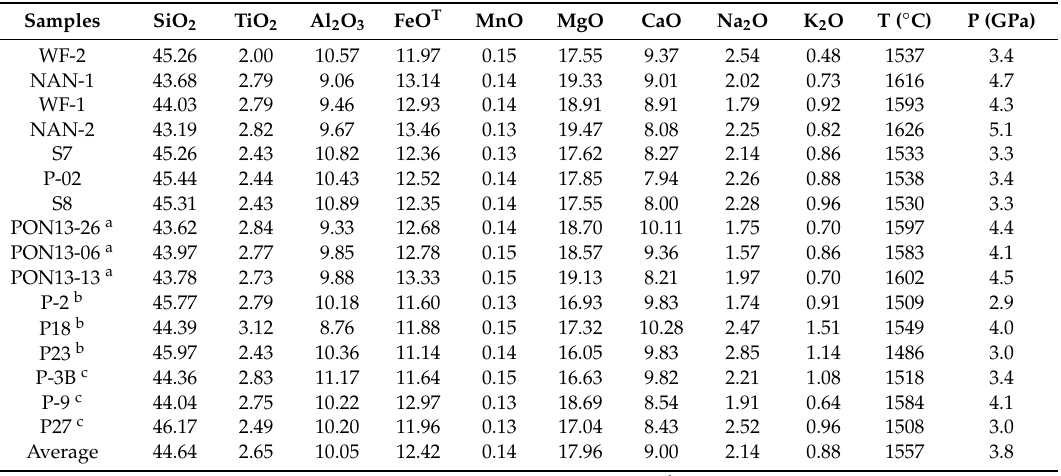
Table 2. Estimated primary melt compositions and mantle melting conditions for the Pohnpei lavas.